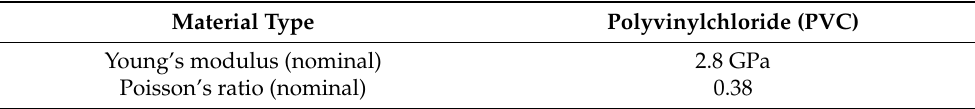
Figure 7. Pipe dimensions and experiment setup showing optical fiber, displacement sensors and threaded rod. Table 2. Material properties of the pipe model.